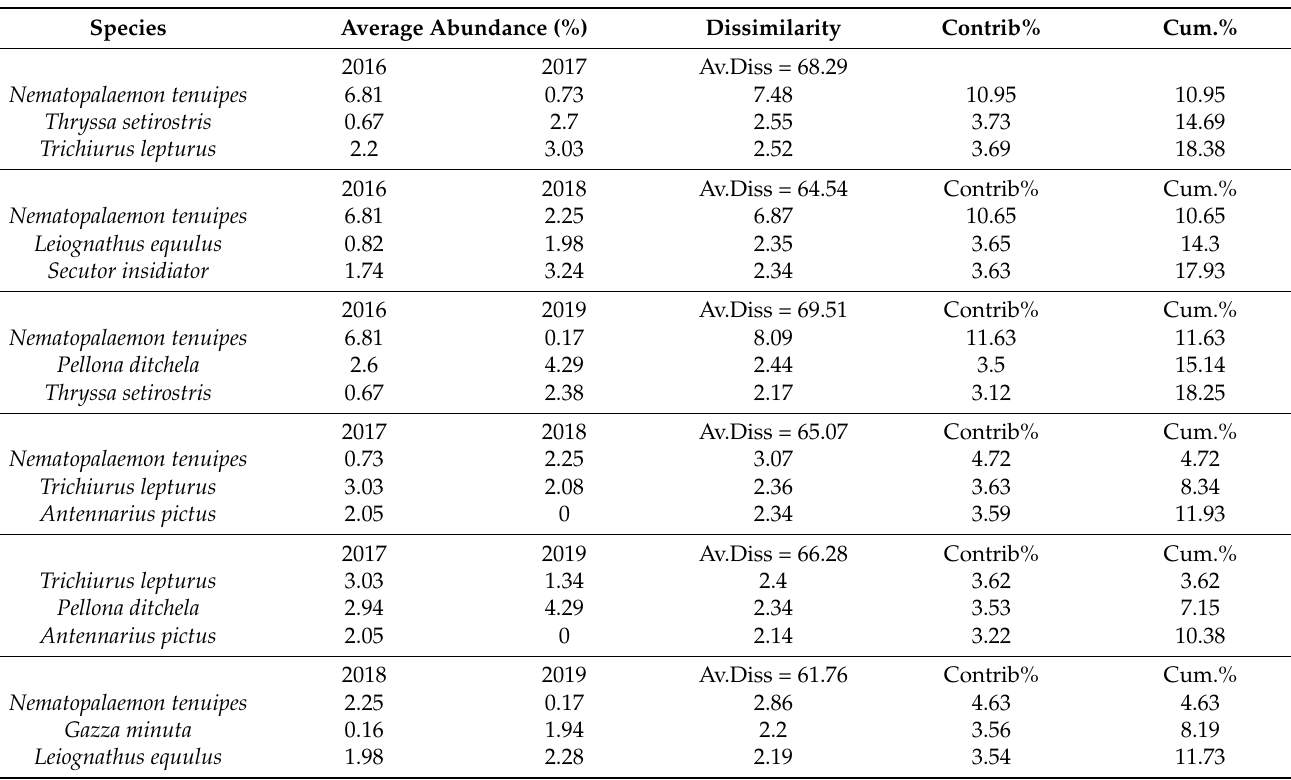
Table 5. Summary results of SIMPER showing the average dissimilarity in the discarded species com- position across the years studied and three species that contributed most to the overall